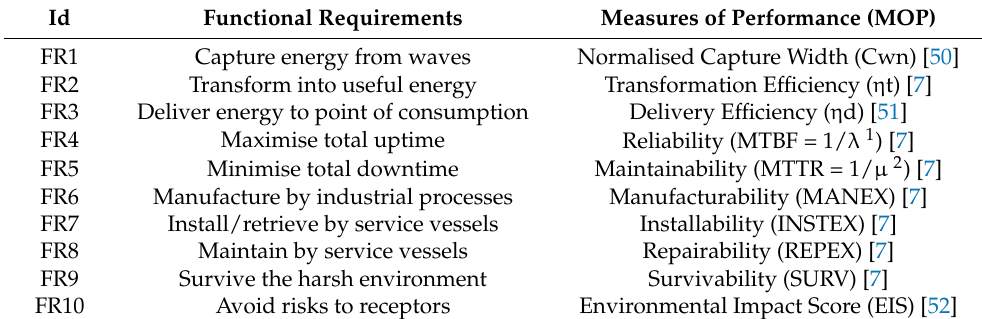
Table 9. Functional Requirements and Metrics.